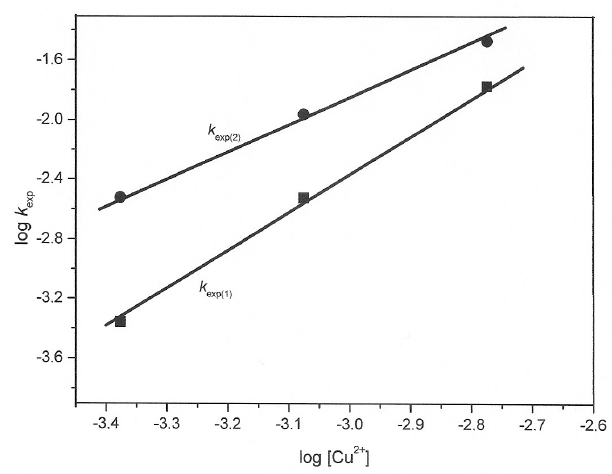
Figure 9. Effect of the initial Cu 2+ concentration on thiosulfate transformation: order of the reaction.